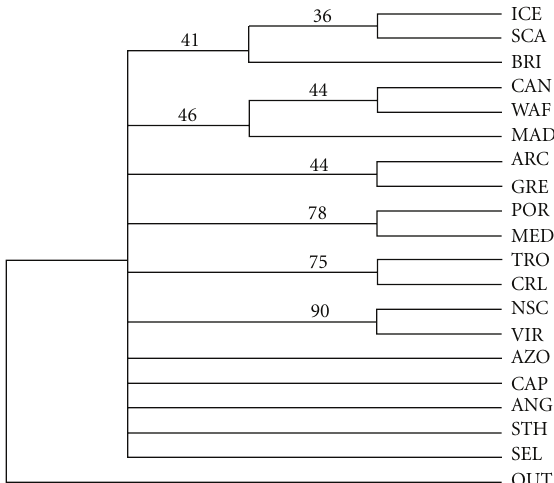
Figure 2: Consensus tree with bootstrap values for the deep Ris- soidae species, abbreviations as in Table